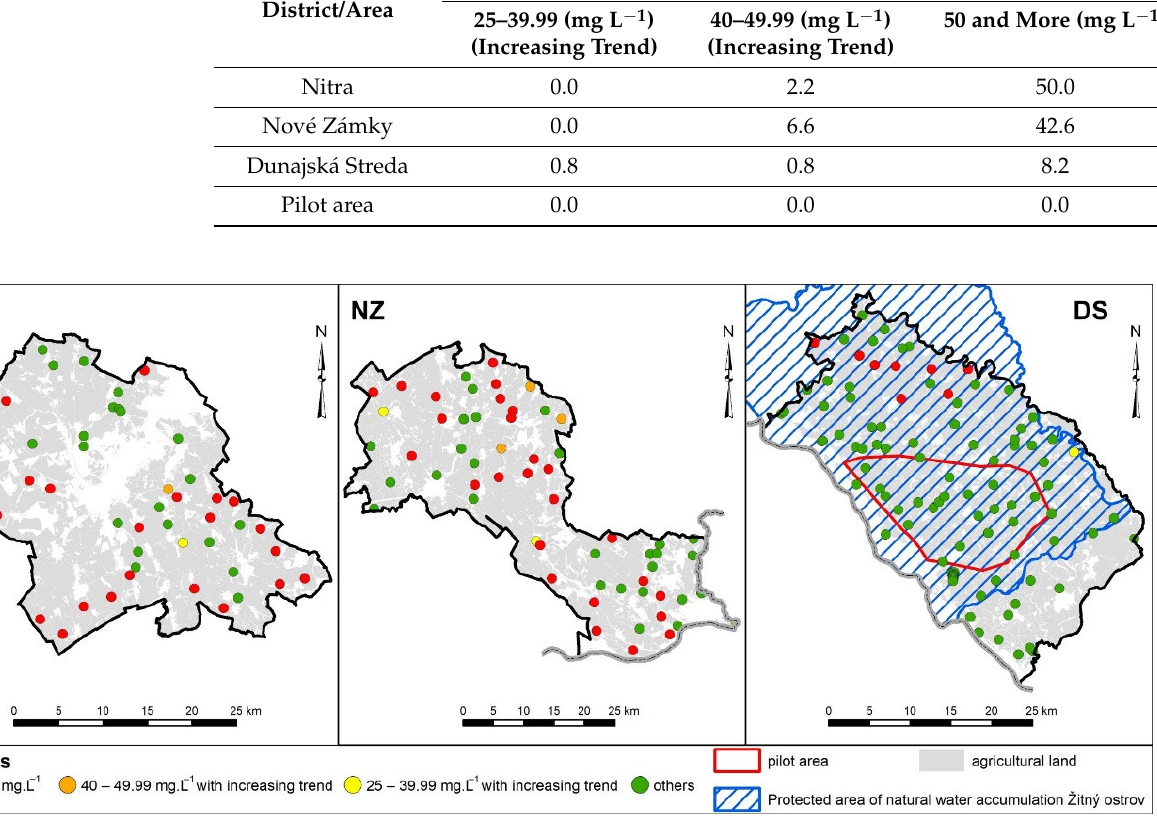
Figure 2. Spatial distribution of defined average nitrate concentrations in groundwater in 2016–2019 within selected districts and pilot area. Table 1. Relative share of groundwater monitoring sites (%) with defined nitrate concentrations (mg L −1 ) of the total within UAL of selected districts and pilot area.